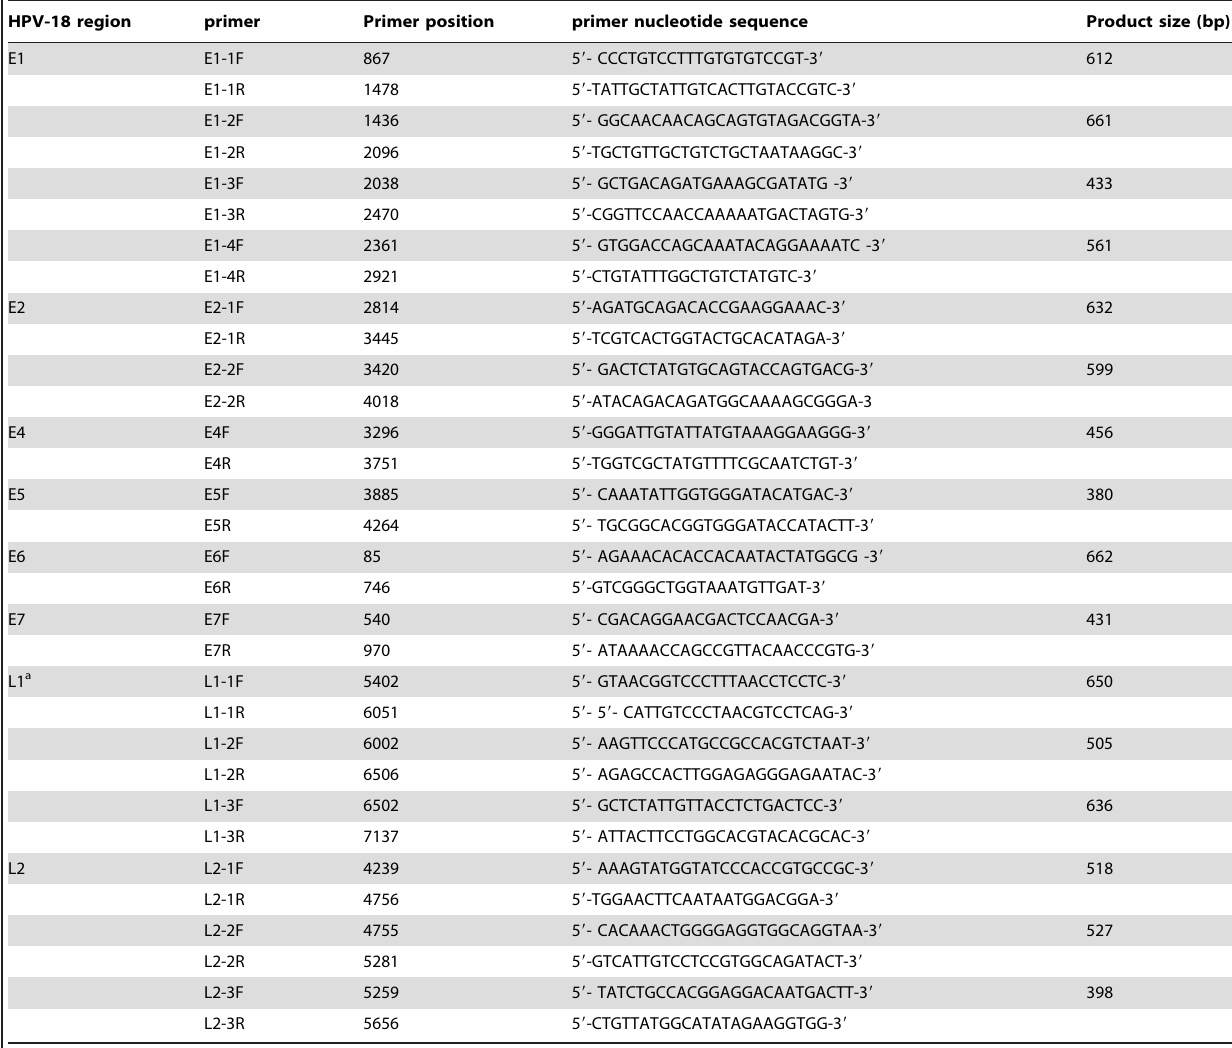
Table 1. Primers used for